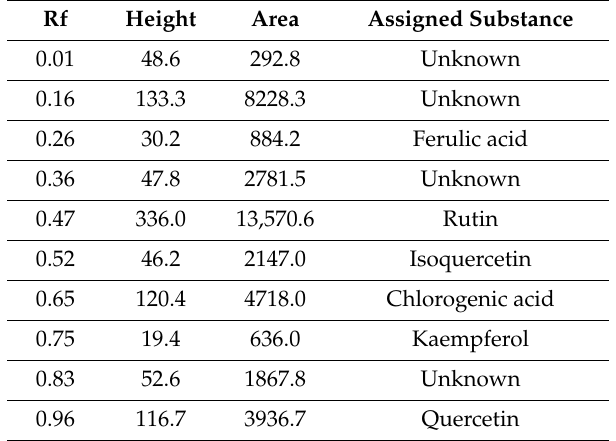
Table 2. HPTLC flavonoid-specific profile of A. aethiopicum methanolic extract.